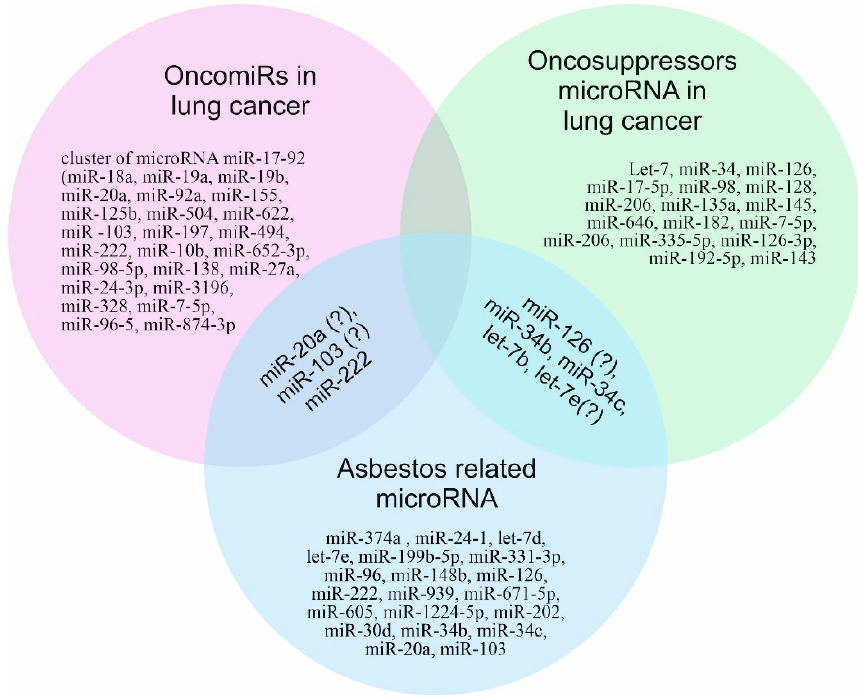
Figure 2. Asbestos-related lung cancer microRNAs.